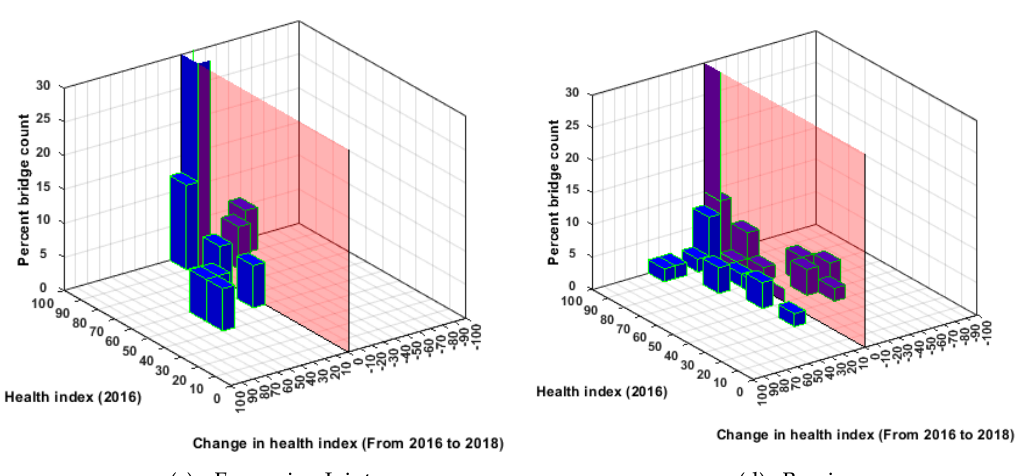
Figure 16. NHS bridge performance in New York. ( a ) Overall bridge; ( b ) concrete deck; ( c ) expansion joint; ( d ) bearing.